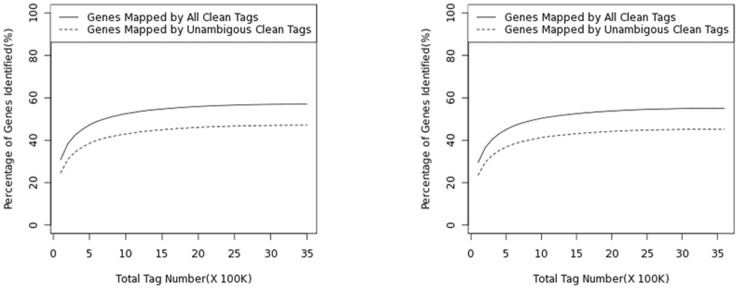
Saturation evaluation of differential expression.The left figure is PF and the right figure is IF.